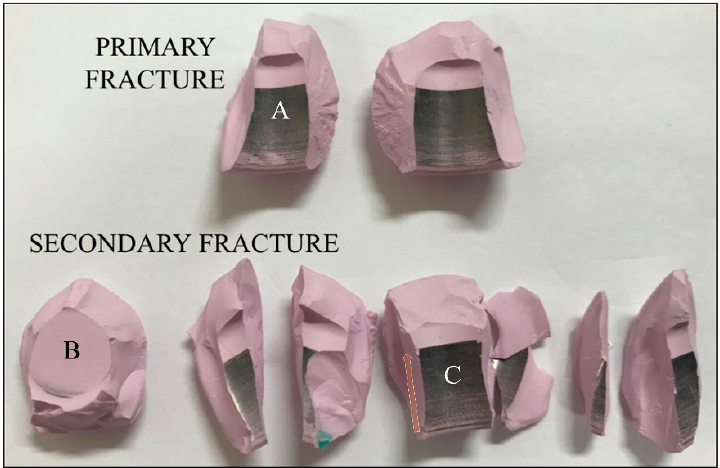
Figure 4. Main fragments of a burst-strength-tested ceramic femoral head, demonstrating primary and secondary fracture surfaces. A, B, and C mark a fragment with metallic stains, the top surface of the bore and some oriented marks, respectively.